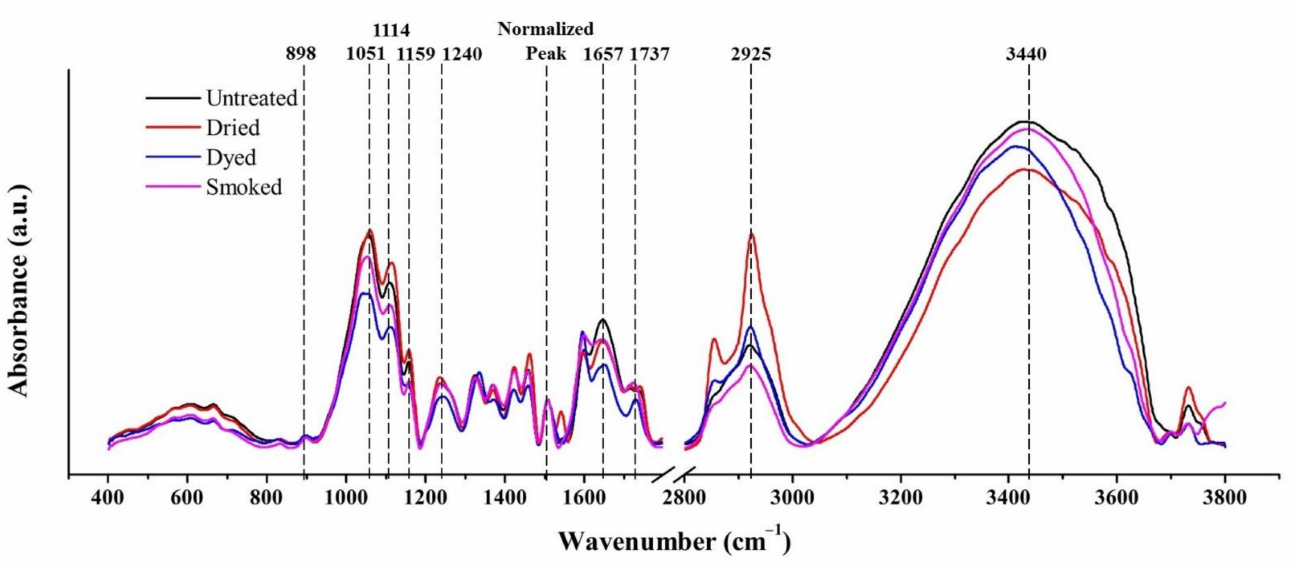
Figure 5. FTIR spectra in the range of 400–1800 cm − 1 and 2800–3800 cm − 1 , obtained from the innermost layers of untreated and modified bamboo specimens.